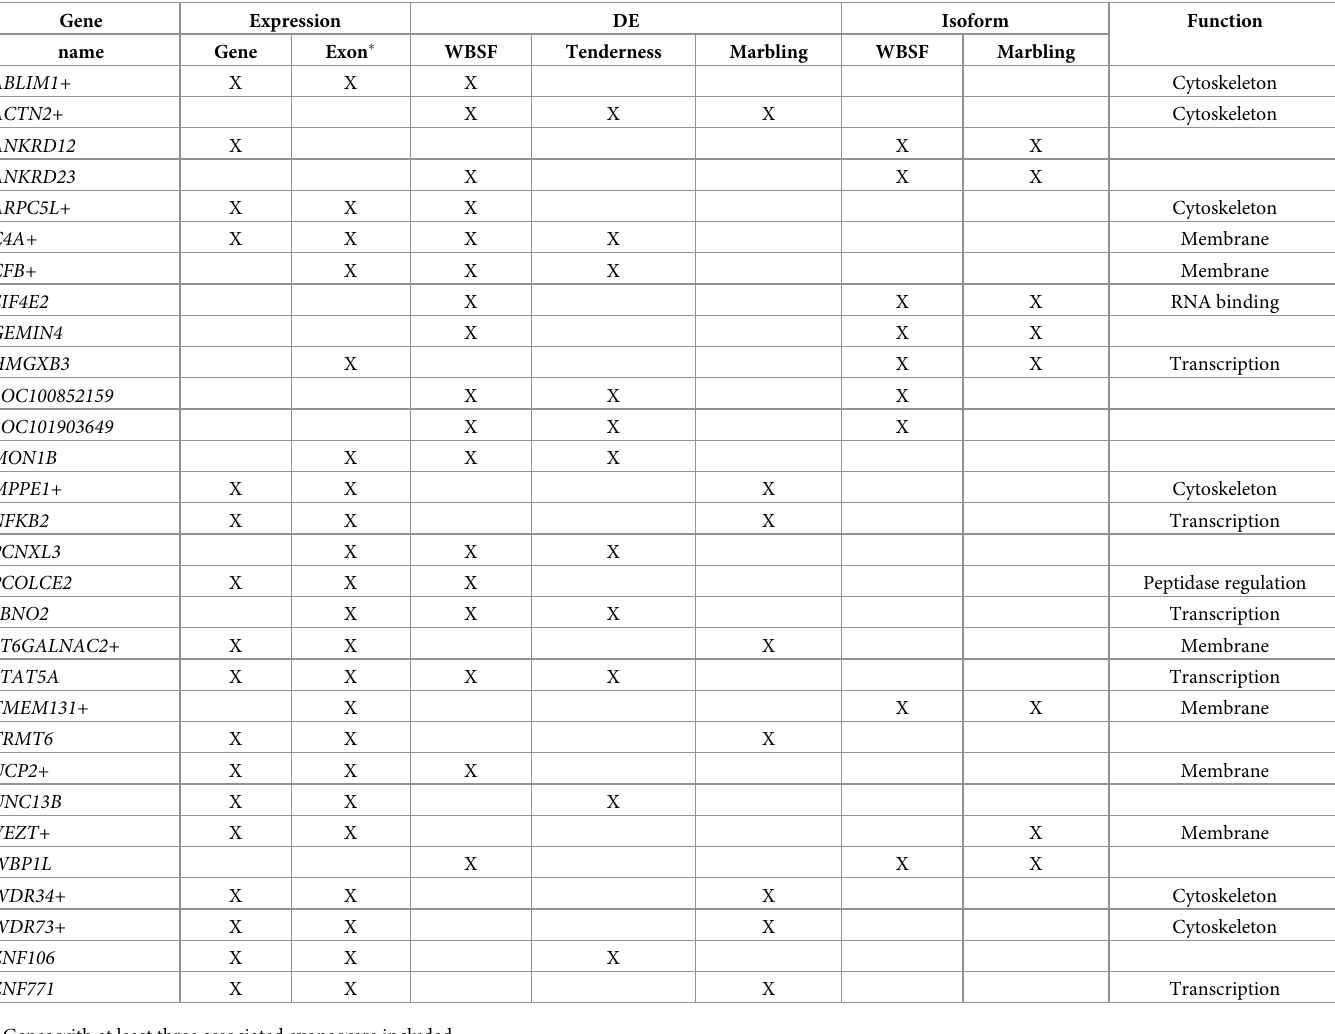
Table 2. Genes that were identified at least three times using the expression association and DE analysis approach for meat quality related phenotypes. Meat quality was recorded in longissimus dorsi muscle from a multibreed Angus-Brahman